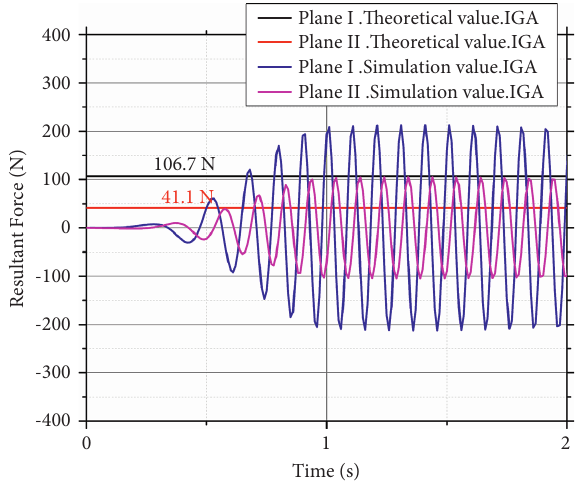
Figure 12: Comparison of IGA optimization results between theoretical and simulation